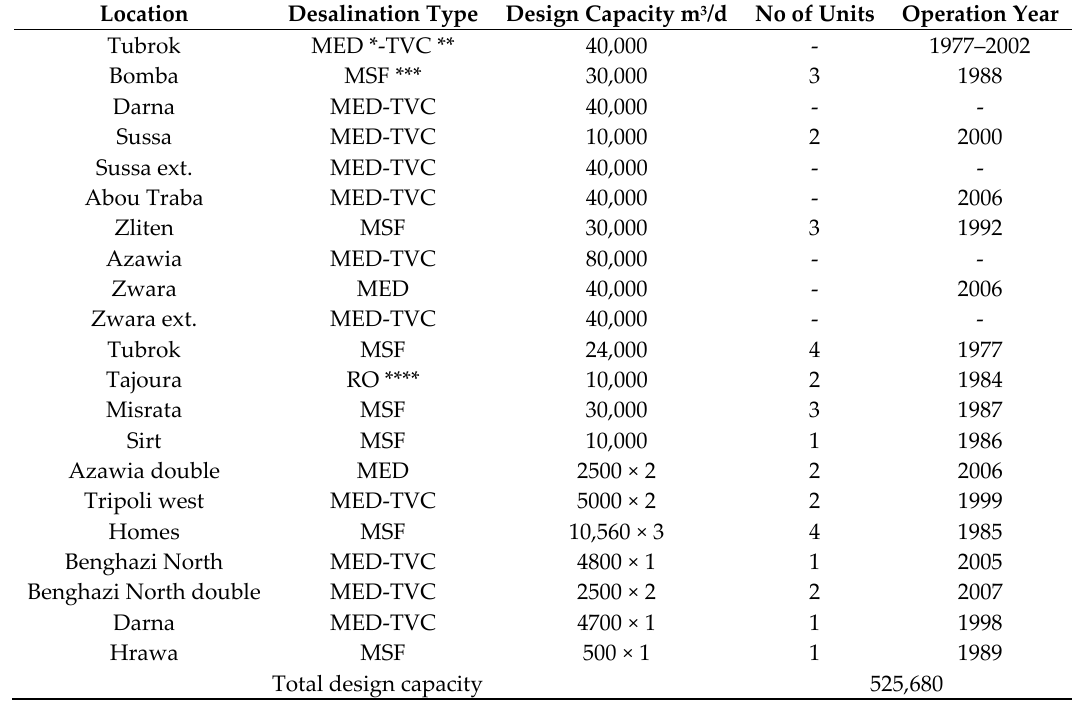
Table 3. The existing operating desalination plants in